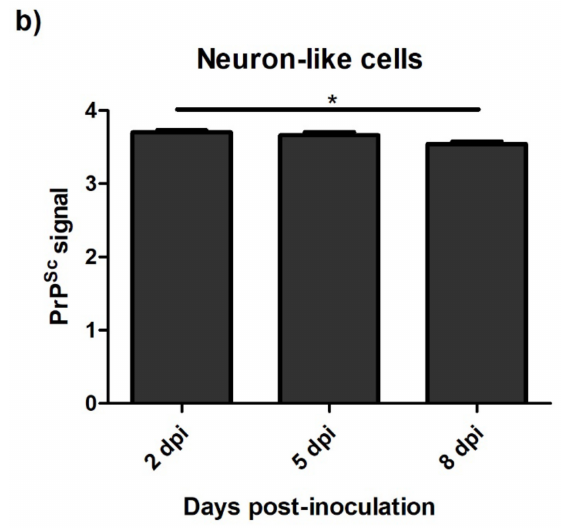
Figure 6. PrP Sc levels measured by ELISA in oBM-MSCs ( a ) and neuron-like cells ( b ) 2, 5, and 8 days after prion infection. Data are shown as mean values ± SEM. * p < 0.05; ** p < 0.01.